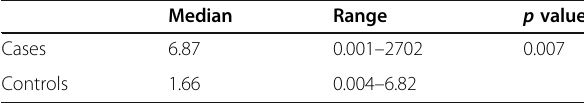
Table 2 HOTAIR gene expression in cases and controls